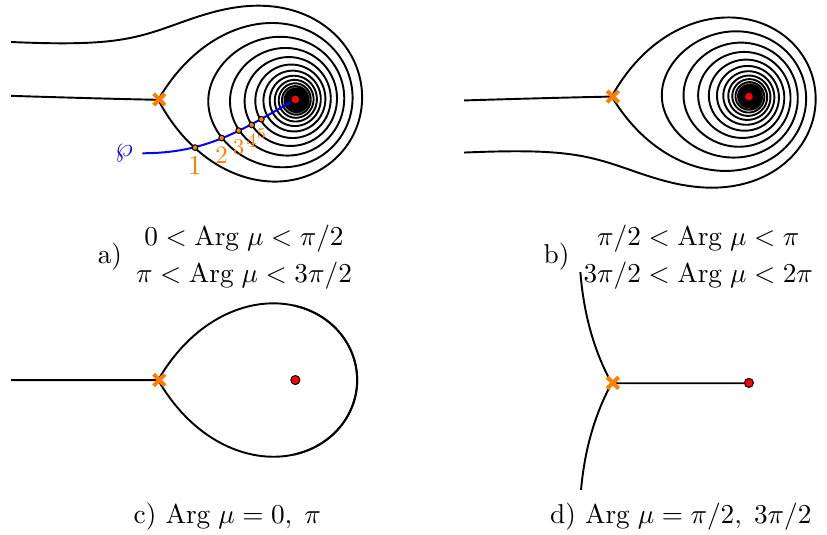
Figure 6 . Spectral network topologies in z -plane for equivariant CP 1